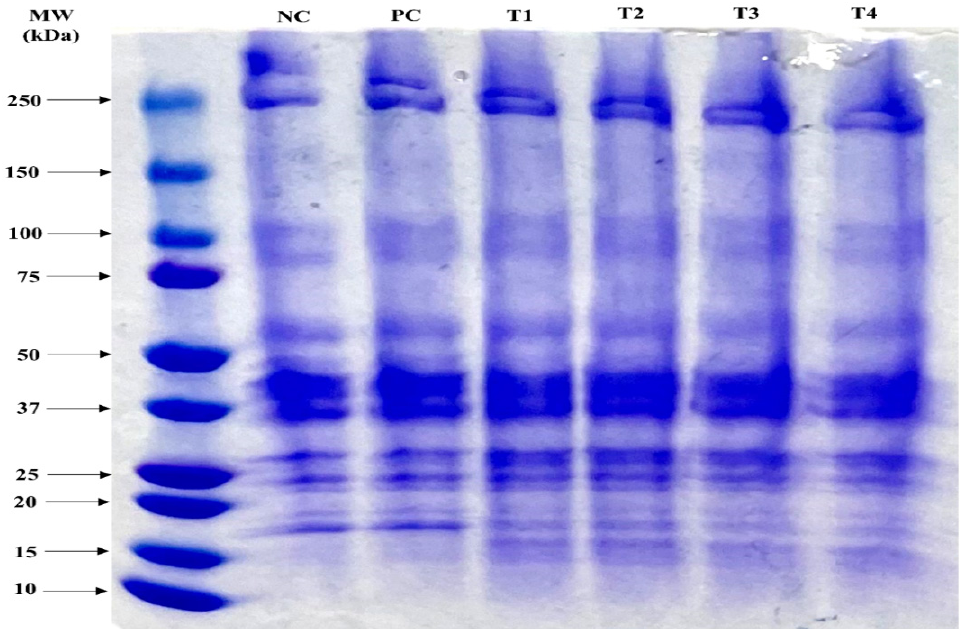
Figure 1. Effects of grafted insect protein and eggshell powder on protein molecular weight distribution of phosphate-free meat emulsion. NC: negative control not containing phosphate, PC; positive control containing 0.15% phosphate, T1: meat emulsion containing 0.10% grafted insect protein (GI), T2: meat emulsion containing 0.1% GI and 0.1% eggshell powder (ES), T3: meat emulsion containing 0.15% GI, T4: meat emulsion containing 0.15% GI and 0.1% ES.